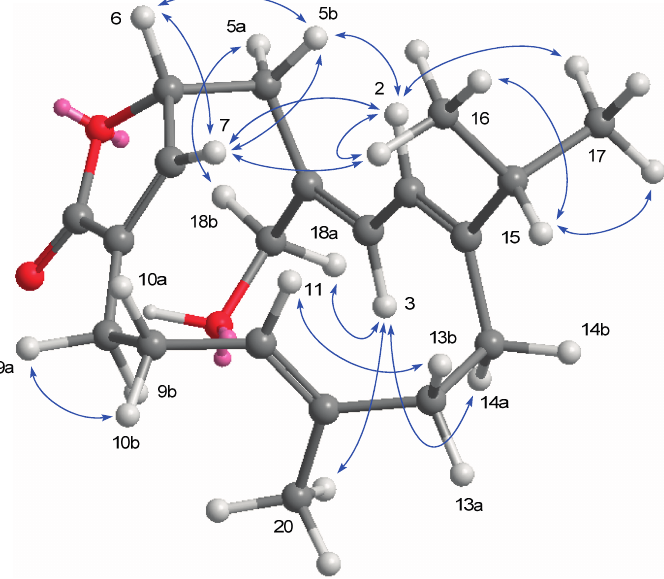
Figure 5. Selected NOESY correlations and computer-generated perspective model using MM2 force field calculations for 4